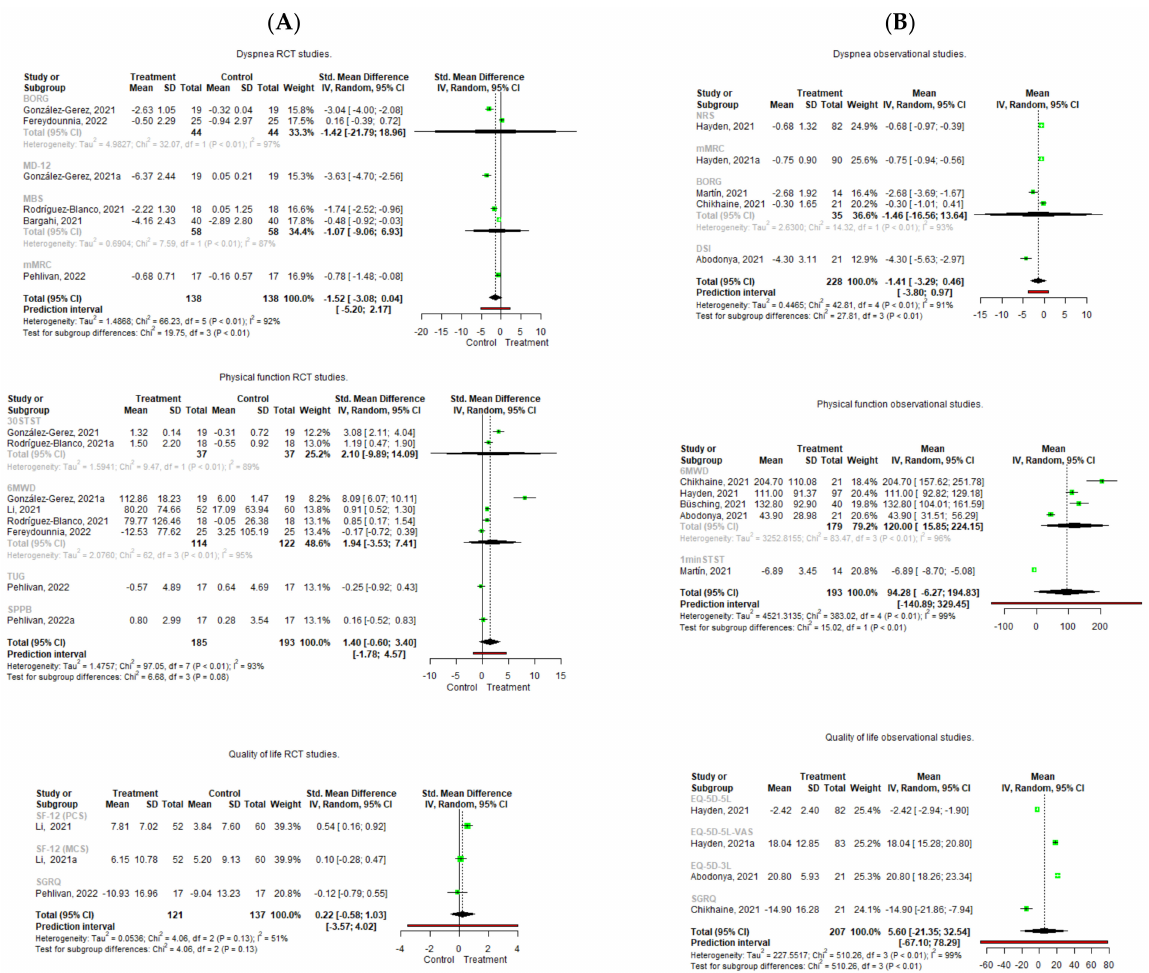
Figure 5. Subgroup meta-analysis of the effect of Pulmonary Rehabilitation in post-acute patients with COVID-19 related to physical function, dyspnea, and quality of life. ( A ) RCTs assessed; ( B ) Observational studies